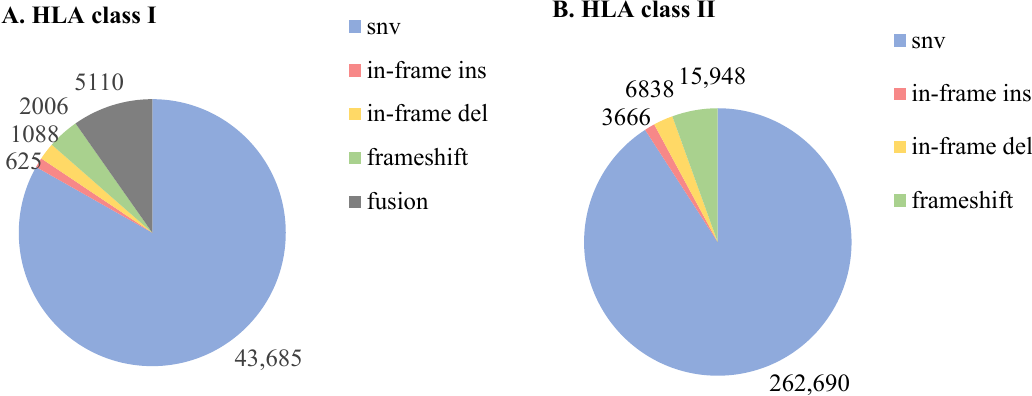
Figure 3. Source distribution of candidate neoantigens: ( A ). HLA class I binding neoantigens (8–11-mer) ( B ). HLA class II binding neoantigens (15–30-mer).